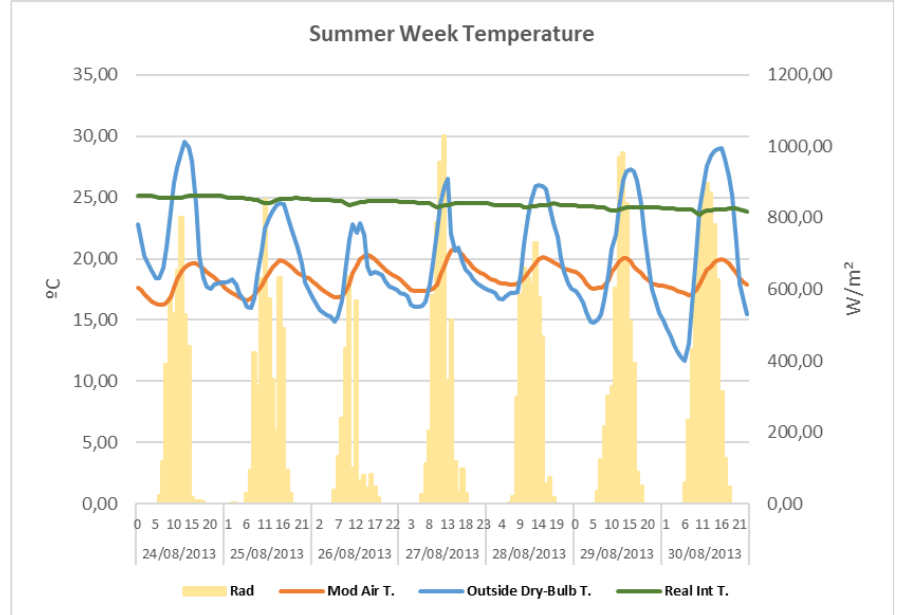
Figure 24. Hourly solar radiation, outdoor temperatures, and real and modeled indoor temperatures (summer).